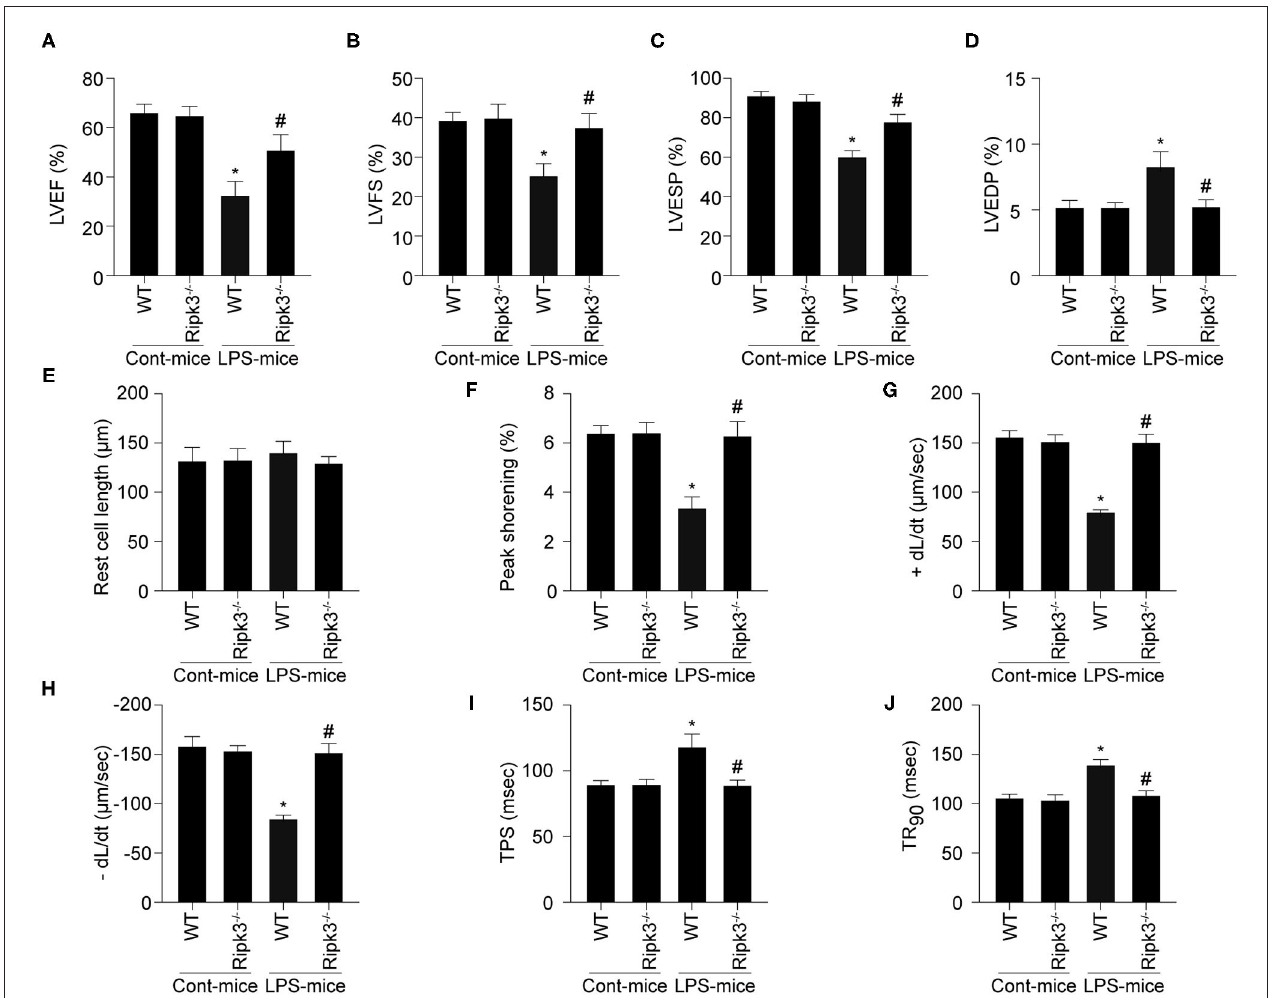
FIGURE 2 | LPS-induced cardiac dysfunction could be improved by RIPK3 deletion ( n = 6/group). (A–D) Cardiac function was measured via echocardiography. (E–J) Cardiomyocyte mechanical parameters were monitored using a VEVO 2,100 high-resolution imaging system. Cardiomyocytes were isolated from LPS-treated mice and melatonin-treated mice. Then, the resting cell length, peak shortening, time-to-90% re-lengthening (TR90), time-to- shortening (TPS), the maximal velocity of shortening ( + dL/dt) and the maximal velocity of re-lengthening (-dL/dt) were determined. * p < 0.05 vs. WT group. # p < 0.05 vs. WT + LPS